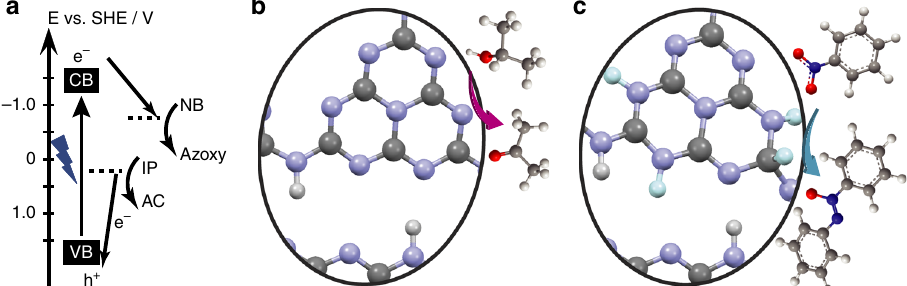
Fig. 3 Proposed reaction mechanisms. a Energy scheme of the photocatalytic nitrobenzene reduction on g-C 3 N 4 . The redox potentials of nitrobenzene (NB) to azoxybenzene plus isopropanol (IP) to acetone (AC), and the CB and VB positions are referenced to the SHE 32,33 . b and c suggested possible active sites for isopropanol oxidation and nitrobenzene reduction according to calculations. Grey: C, light purple: N, white: structural H, light blue: surface adsorbed H (H ads